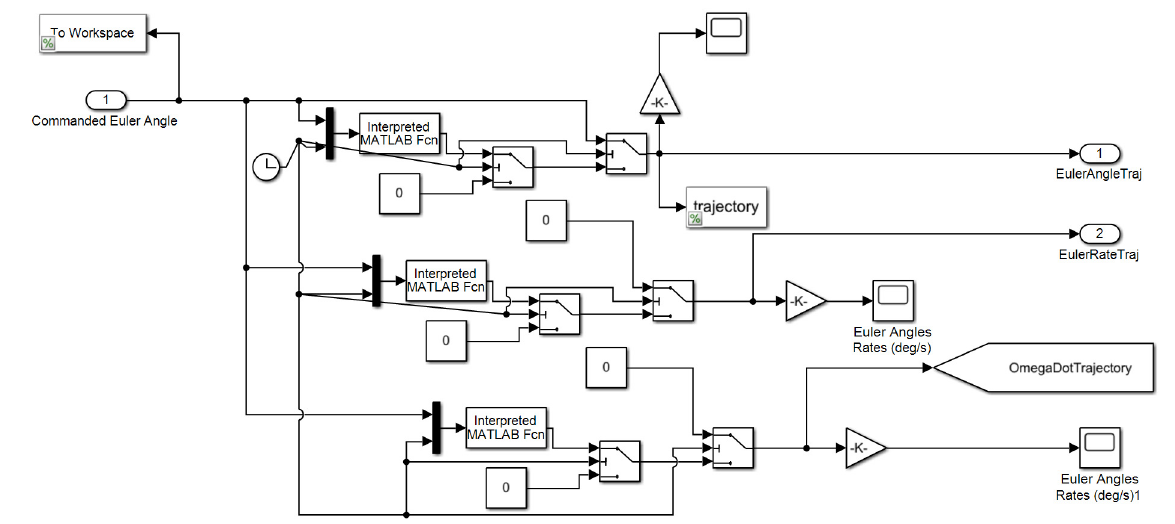
Figure A2. Generate Trajectory subsystem in Figure A1.